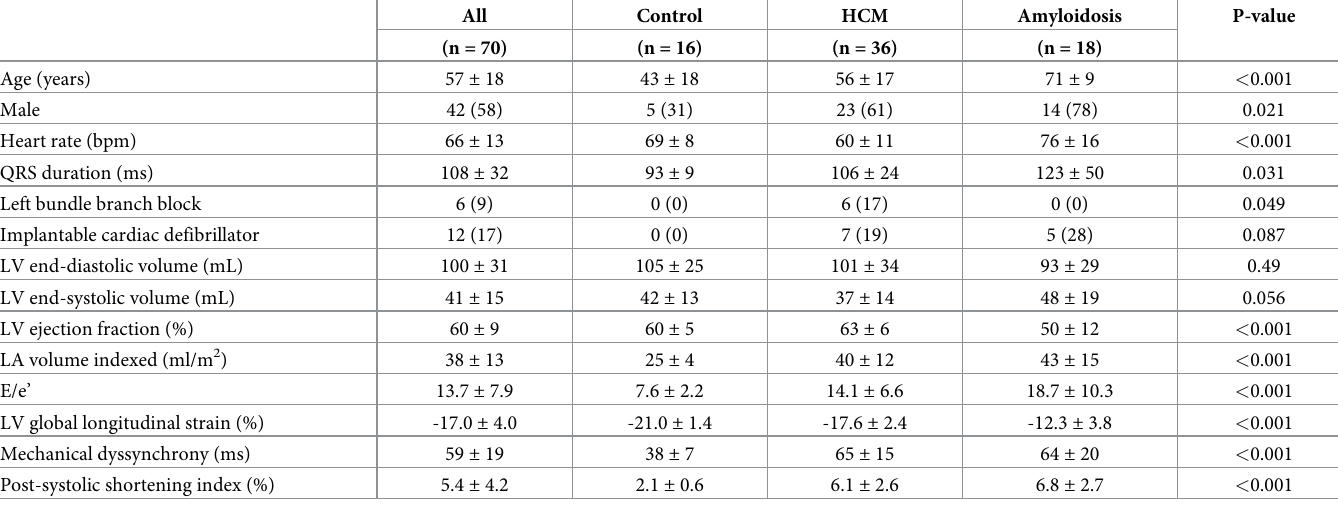
Table 1. Cohort clinical and echocardiography characteristics.